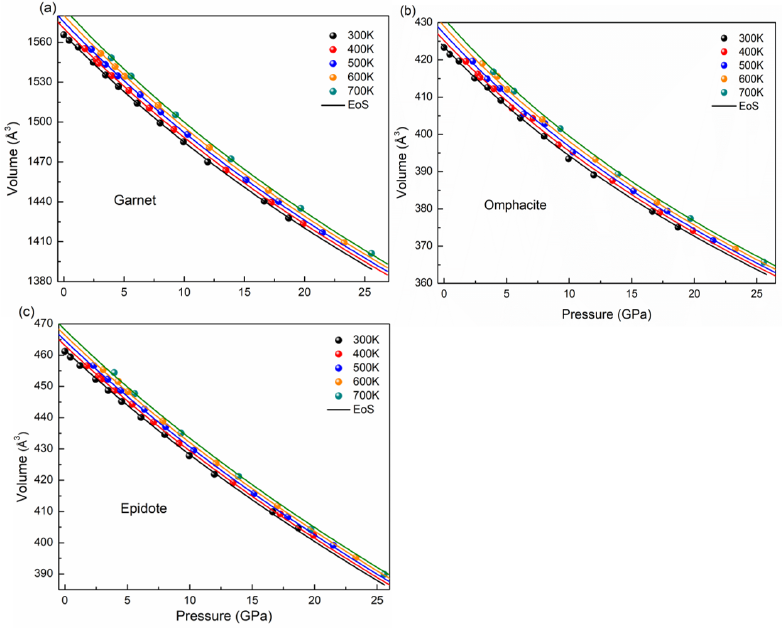
Figure 3. Pressure–volume–temperature relations of garnet (a) , omphacite (b) , and epidote (c) . Isothermal compression curves are calculated by using the thermoelastic parameters obtained in this